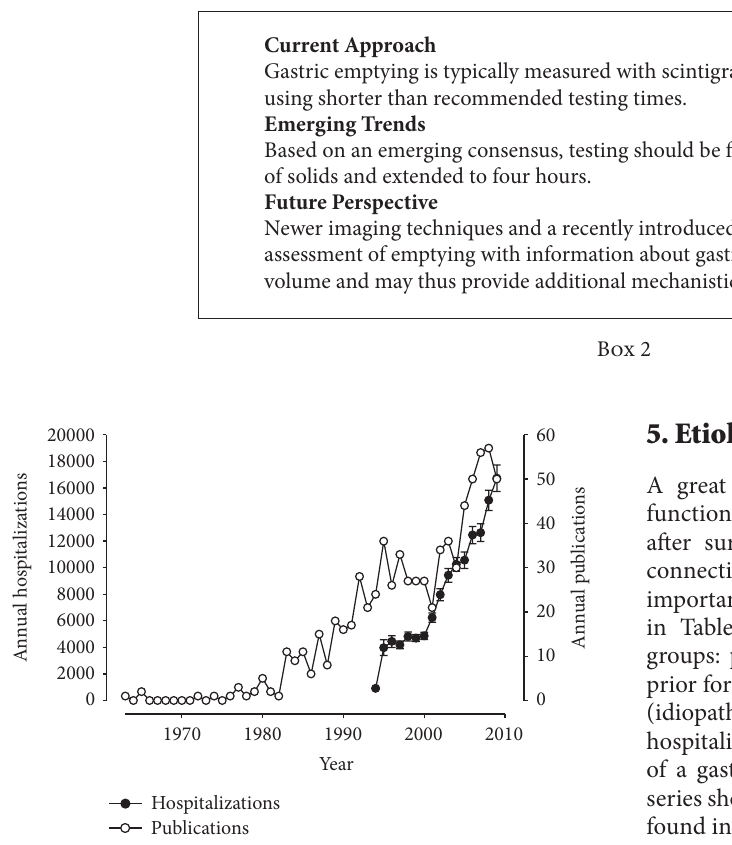
F 2: Time trends in abstracted English-language publications about gastroparesis retrieved from the PubMed data bank (white circles) and reported annual hospitalizations (black circles) for gastroparesis as primary diagnosis (based on data from the Nation- wide Inpatient Sample of the Agency for Healthcare Research and Quality).